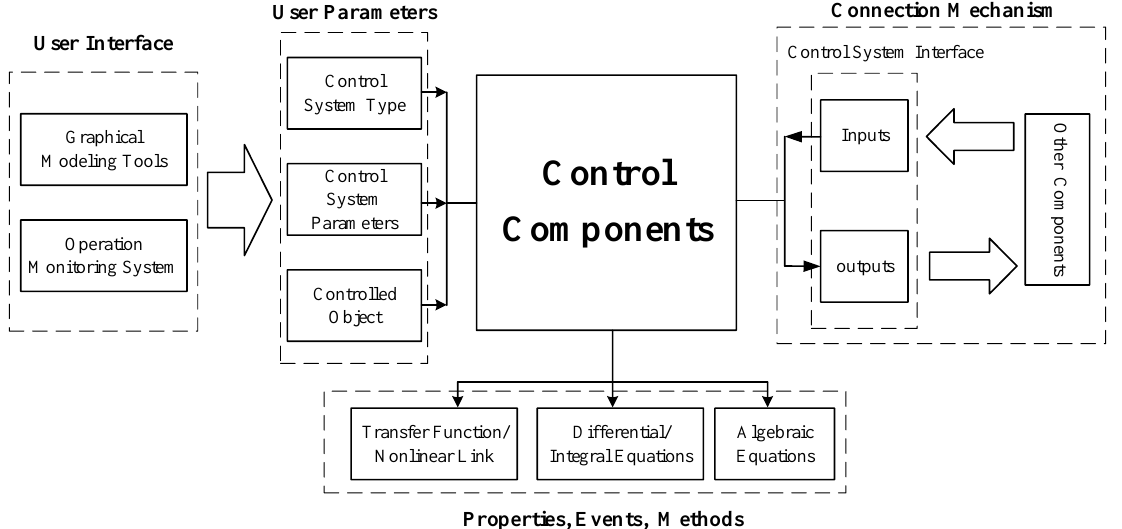
Figure 6. Schematic diagram of the componentization of the control subsystem.